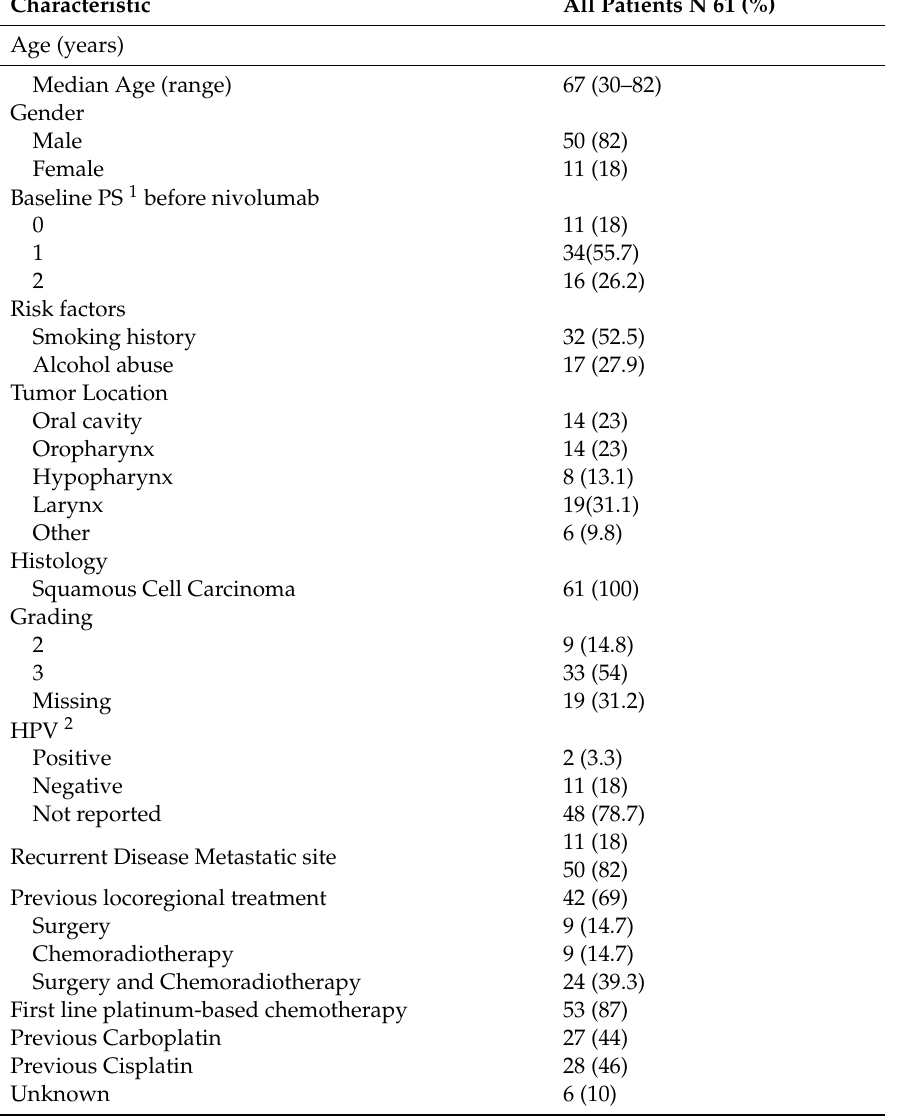
Table 1. Baseline clinicopathological